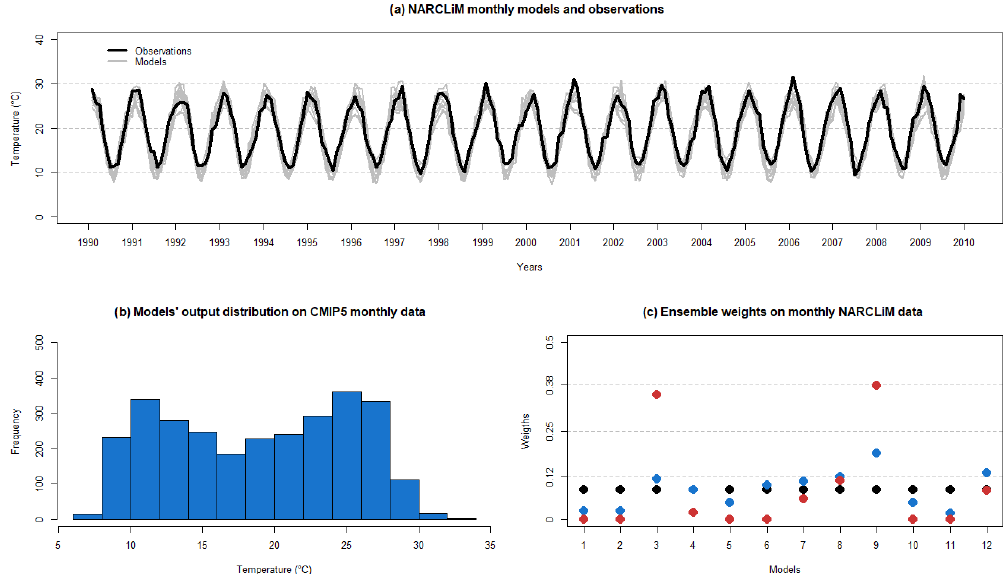
Figure 5. NARCLiM data properties. (a) Model outputs and observations. (b) Model output distribution. (c) AVE, COE and MCE